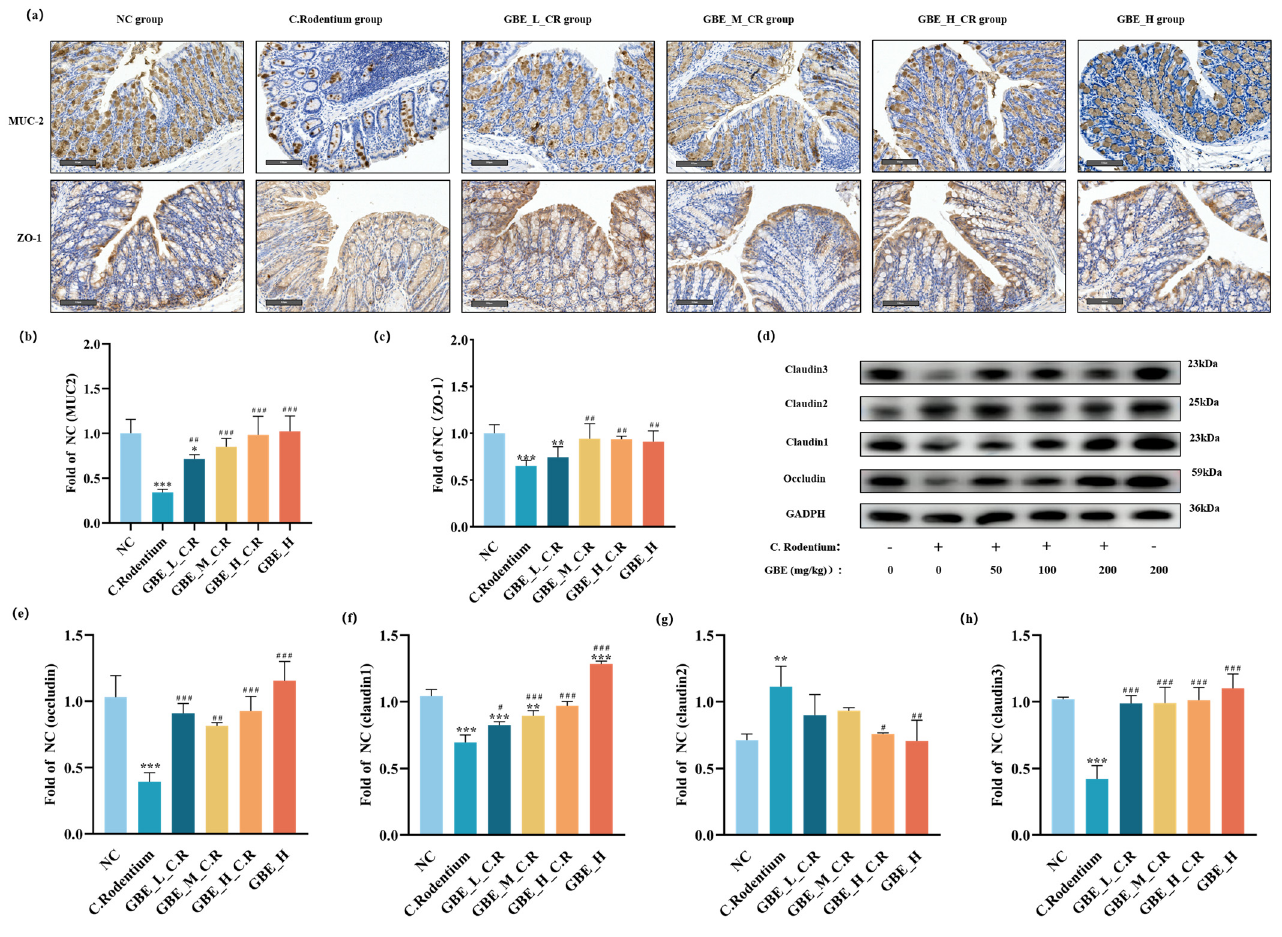
Figure 5. GBE enhanced mouse intestinal barrier function. ( a ) Typical IHC images showing MUC2 and ZO1 (scale bar = 250 µm). The quanti fi cation of MUC2 ( b ) and ZO1 ( c ). ( d ) Typical protein bands for Occludin, Claudin1, Claudin2, and Claudin3. Protein levels of Occludin ( e ), Claudin1 ( f ), Claudin2 ( g ), and Claudin3 ( h ) compared to GAPDH. *** p < 0.001, ** p < 0.01, and * p < 0.05 vs. NC group; ### p < 0.001, ## p < 0.01, and # p < 0.05 vs. C. Rodentium group.